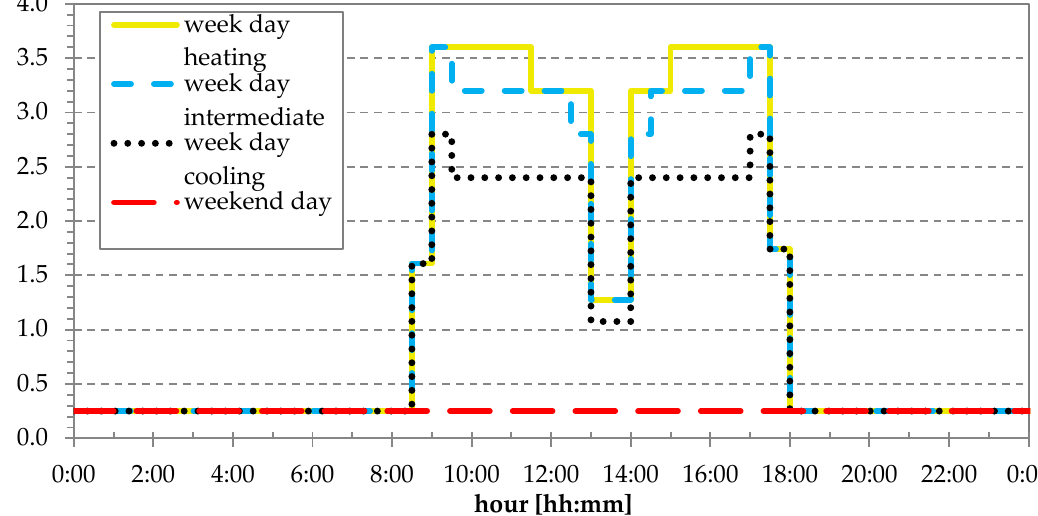
Figure 2. Daily pure electric load profiles (weekdays, weekends) considered for both Naples and Cagliari.